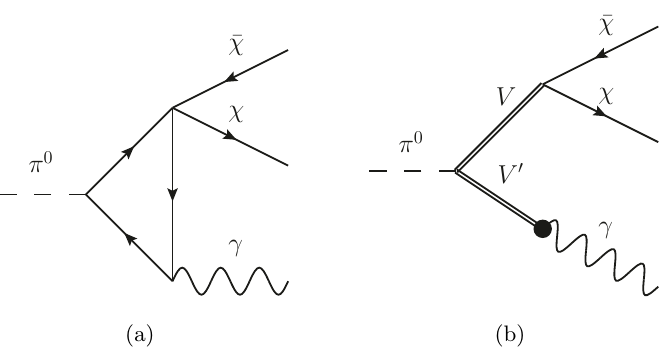
Figure 16 . (a) Triangle diagram approach to the radiative (cid:25) 0 decay. (b) VMD approach radiative to the (cid:25) 0 decay Light meson three-body